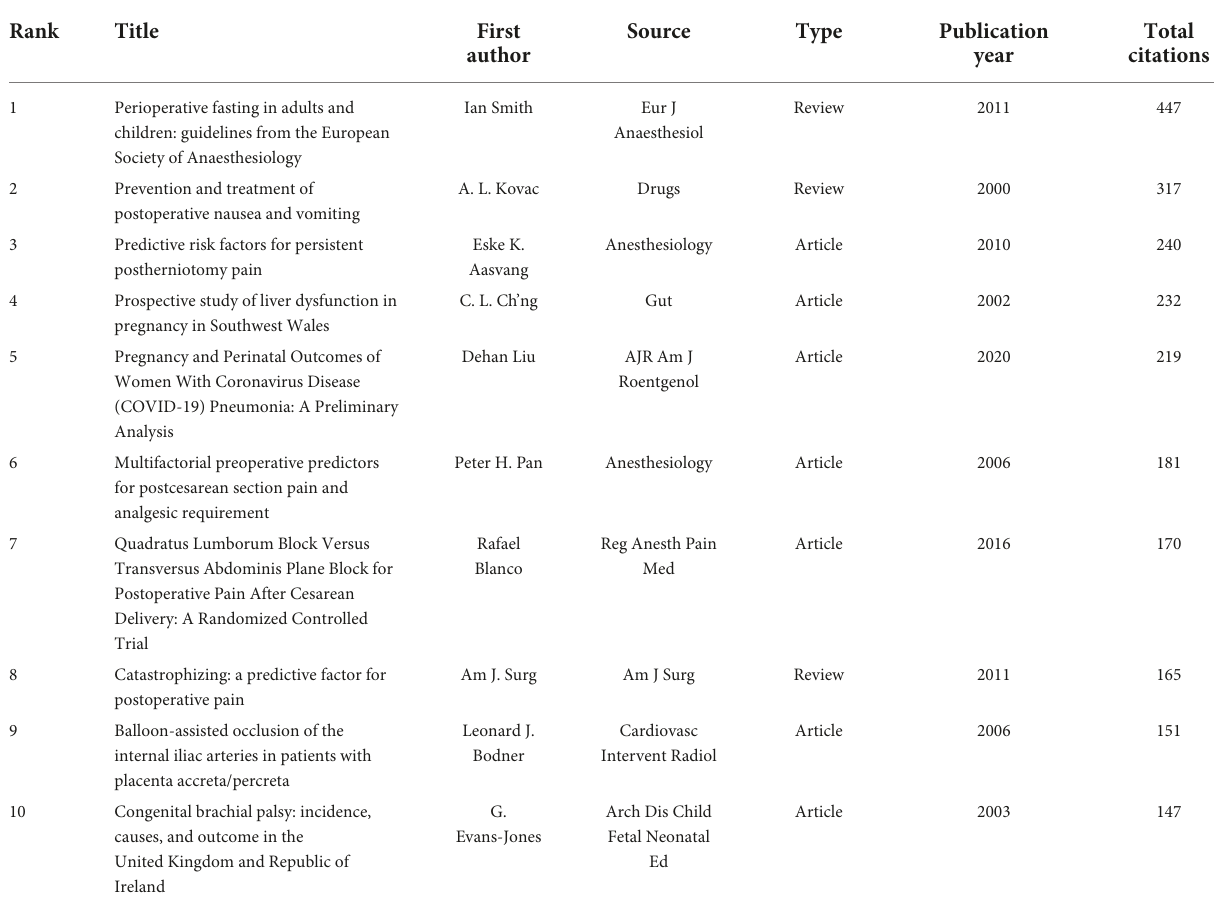
TABLE 6 Top 10 citation analysis of